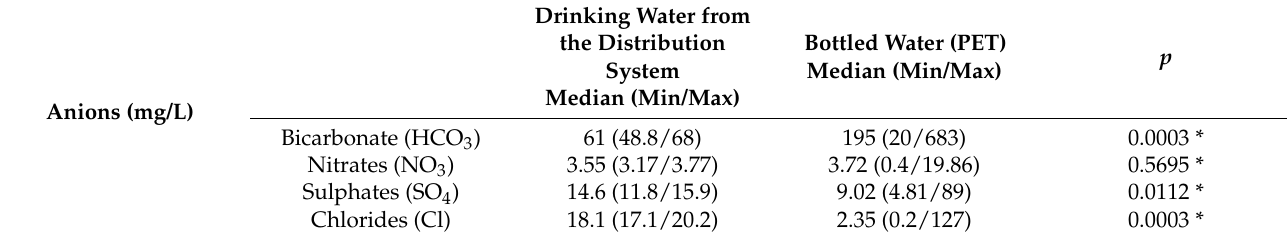
Table 3. Mineral content (anions) in main’s water vs. bottled water.